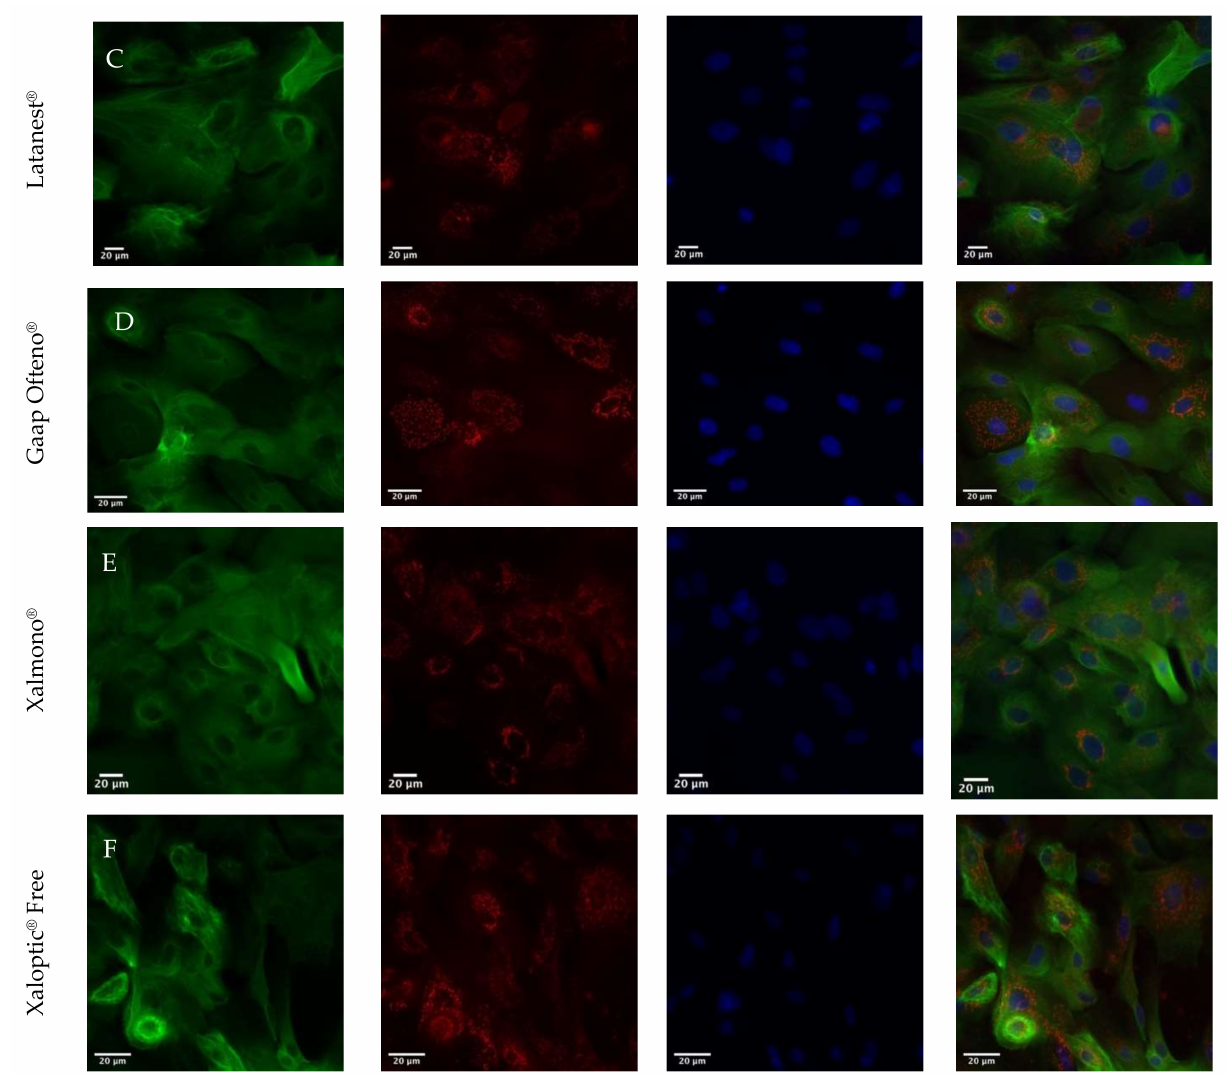
Figure 5. Immunohistochemical staining of human goblet cells, visualizing the cytoskeleton (column 1: Cytokeratin-7, green), mucin (column 2: mucin, red), the nucleus (column 3: DAPI, blue), and merged stainings (column 4: cytokeratin-7 (green), mucin (red) and DAPI (blue)). Cells were treated with diluted (1:7, v / v ) 0.005% latanoprost preservative-free products. ( A ): RPMI media, ( B ): Monoprost ® , ( C ): Latanest ® , ( D ): Gaap Ofteno ® , ( E ): Xalmono ® , and ( F ): Xaloptic ® Free. n =